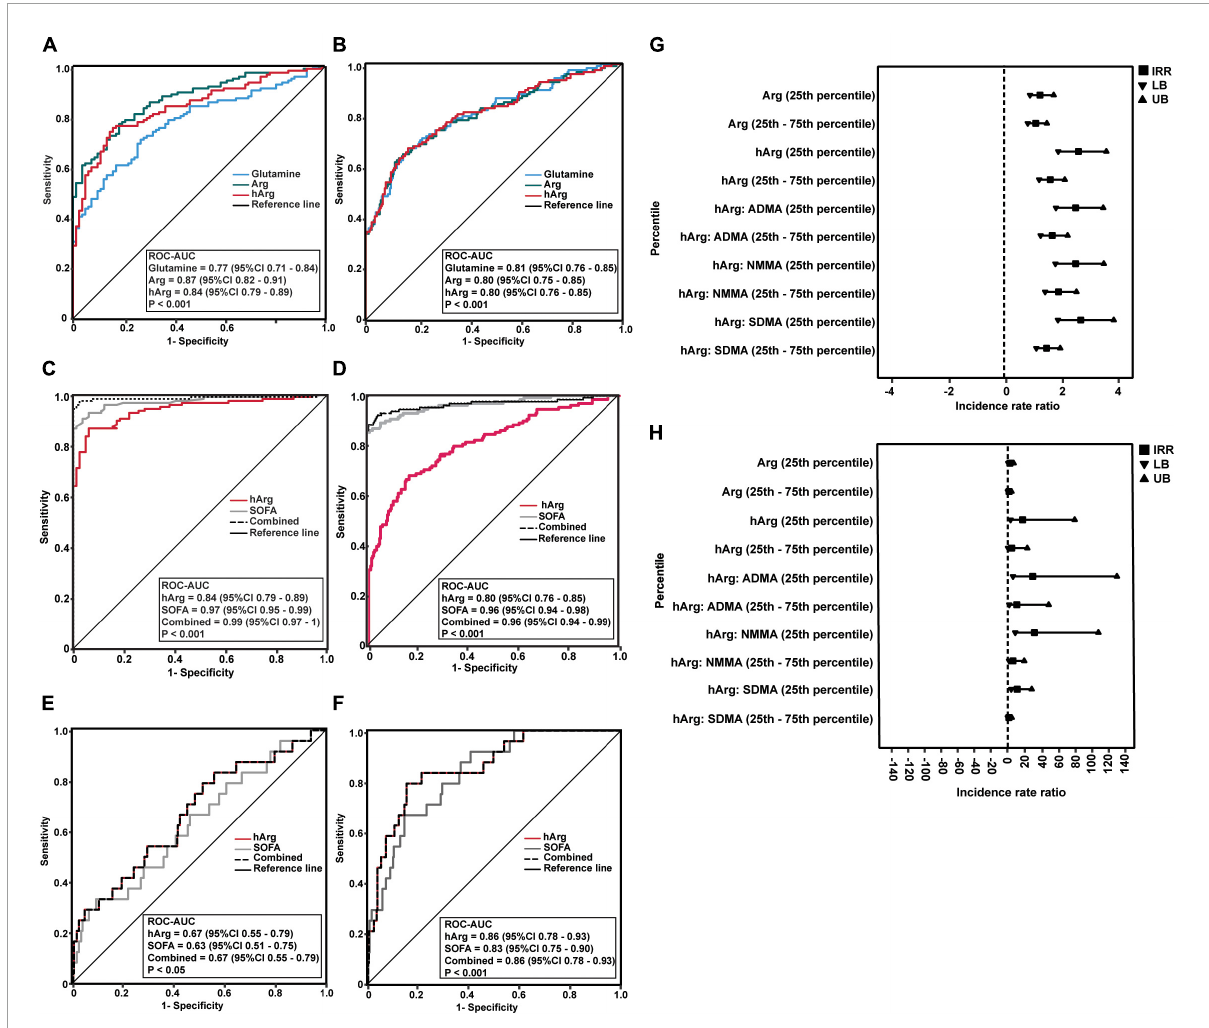
FIGURE2 Predictability of homoarginine (hArg) for sepsis and clinical outcomes. (A–D) Receiver operator characteristic (ROC) curves of glutamine (blue line), arginine (Arg) (green line), and hArg (red line) for sepsis diagnosis. (A,C) ROC of the predicted probability score for sepsis vs. control, without (A) or with sequential organ failure assessment (SOFA) (C) . (B,D) ROC curve of the predicted probability score for sepsis vs. infection, without (B) or with SOFA (D) . ROC curves were adjusted for age, creatinine, and co-morbidities. (E) ROC curves of SOFA (gray line), hArg (red line), and combined (SOFA + hArg) (butted line) for hospital admission. (F) ROC curves of SOFA (gray line), hArg (red line), and combined (SOFA + hArg) (butted line) for intensive care unit (ICU) admission. ROC curves were adjusted for age, creatinine, and comorbidities. (G) Forest plot shows a negative binomial (log link) model and incidence rate ratio for comparison of hospital length of stay (LoS) (days) in patients with sepsis ( N = 128) and infection ( N = 255). a P -value < 0.05 is statistically significant for hospital LoS (days). (H) Negative binomial (log link) model and incidence rate ratio for ICU LoS (days) in patients with sepsis ( N = 128) and infection ( N = 255). b P -value < 0.05 is statistically significant. Each model predicts LoS stratified by low percentile (25th percentile) and intermediate percentile (25th–75th percentile) of Arg and hArg